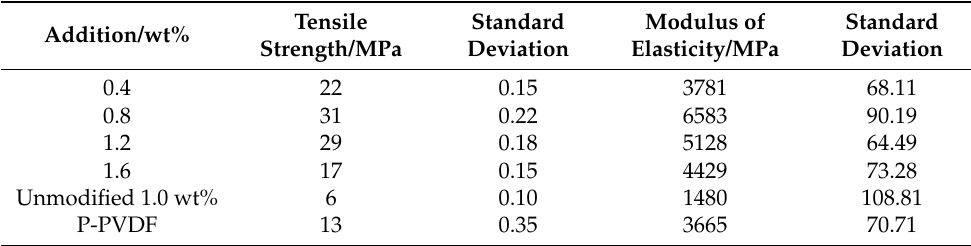
Table 11. Mechanical properties of the fiber membrane at different loading of